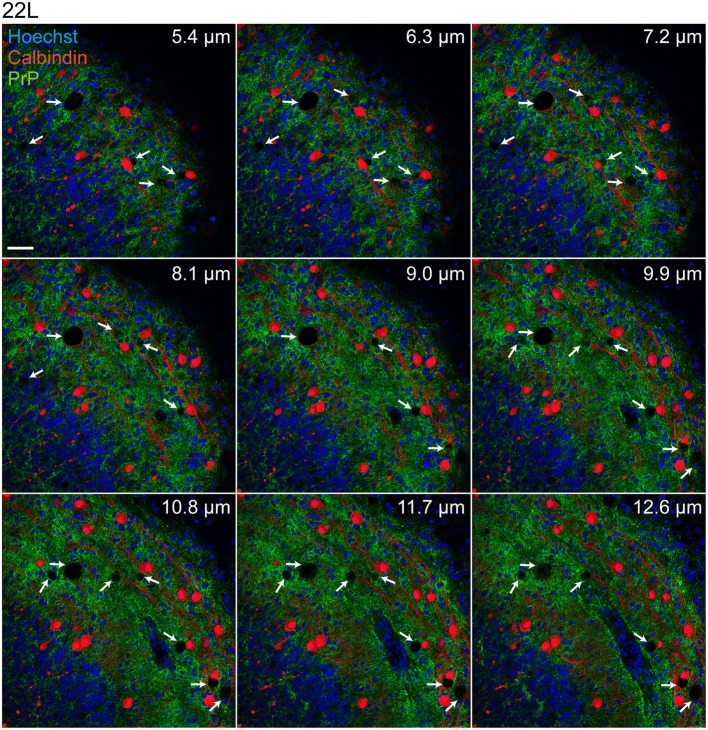
Spongiform changes in cerebellar slices 9 weeks post exposure to 22L prions. Following antigen denaturation, PrPd was detected with mAb 4H11 (green), Purkinje cells were detected using anti-calbindin mAb (red). Nuclei were counterstained with Hoechst. Cerebellar slices exposed to Mock brain homogenate served as controls (data not shown). Samples were analyzed by confocal microscopy using the tile scanning and z-stack functions with identical imaging settings. Consecutive sections through the slice were imaged every 0.9 μm from the bottom to the top. Shown are nine consecutive sections from the z-layer of the slices. Arrows mark vacuolations. Scale bar: 50 μm.